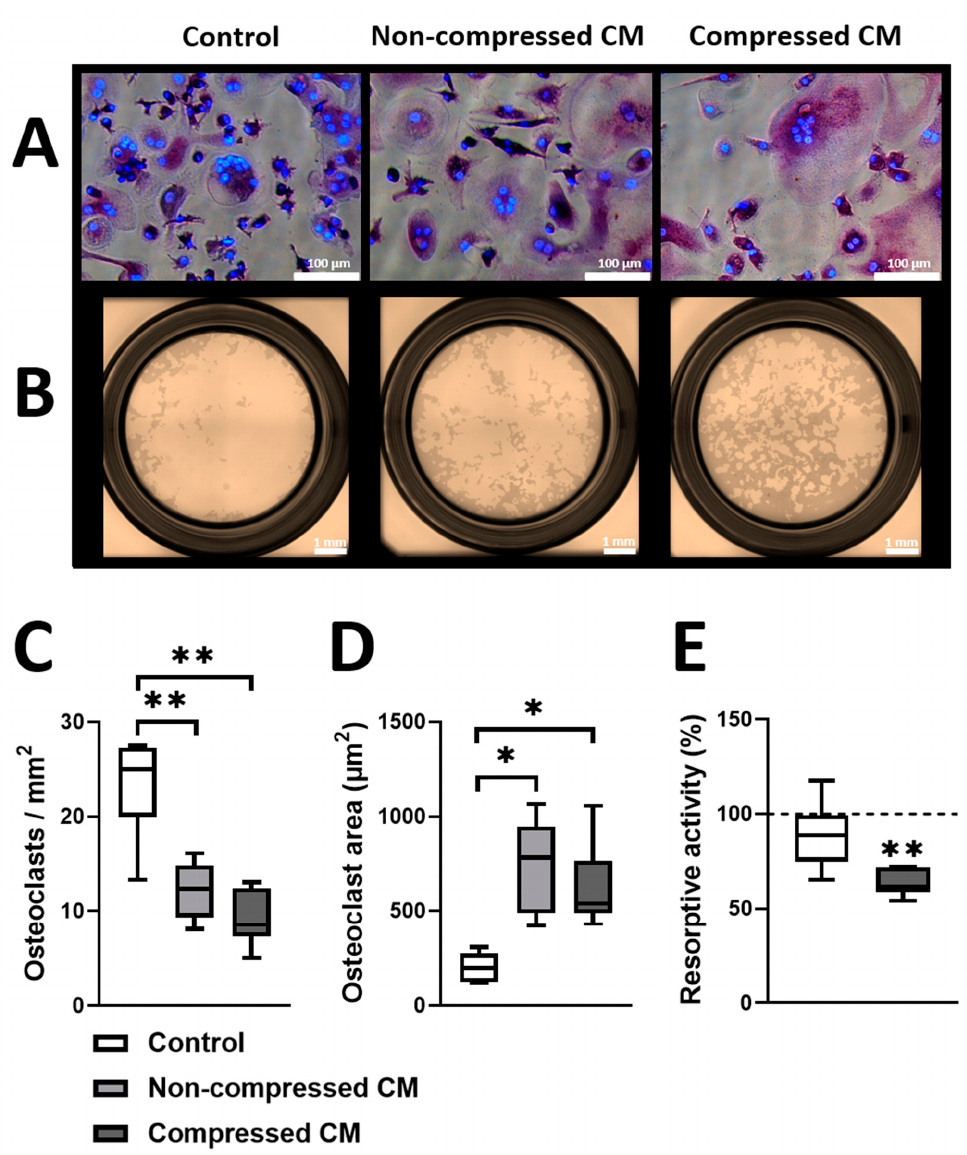
donor 2, and 5 (Figure 4B).